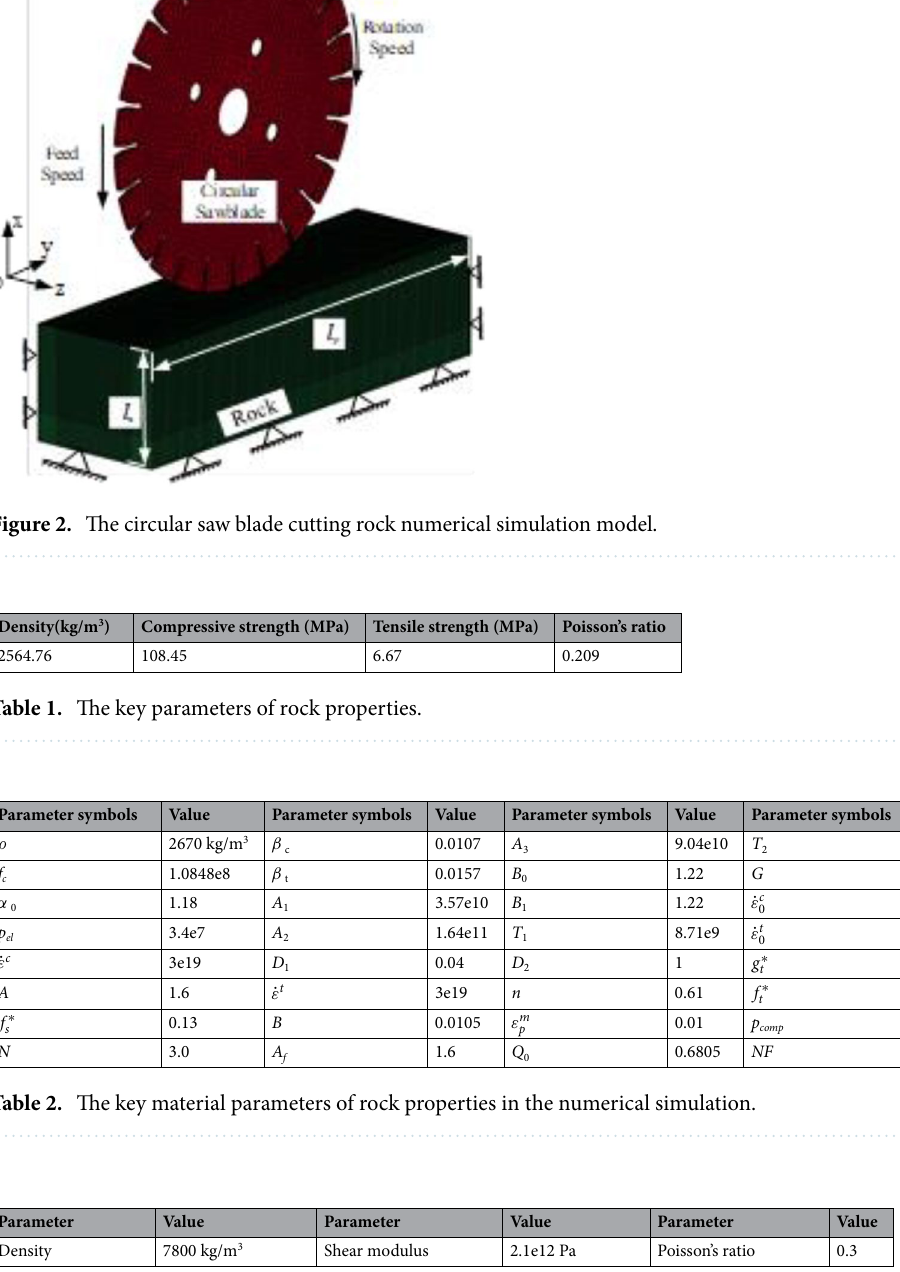
Table 3. The key material parameters of circular saw blade properties in the numerical